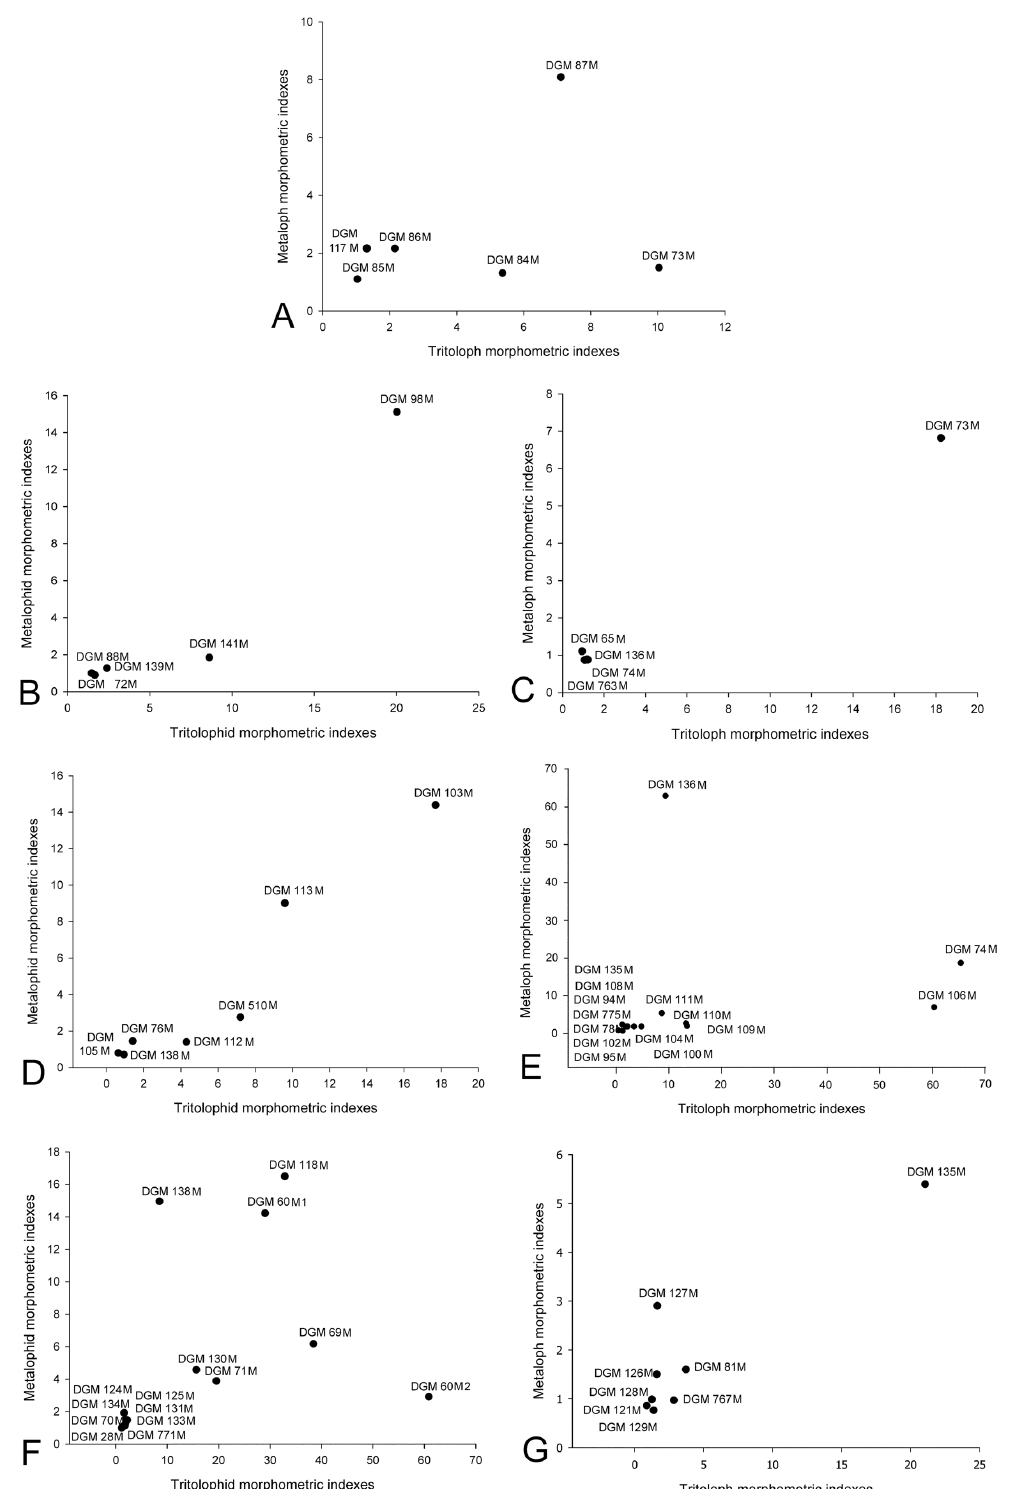
Fig. 4 – Molars wear according to the indexes of wear measured on metaloph (id) and tritoloph (id) of the mastodons from the QAA. A) The upper deciduous molar scatterplot. B) The lower first molar. C) The upper first molars. D) The lower second molars. E) The upper second molars. F) The lower third molars. G) The upper third